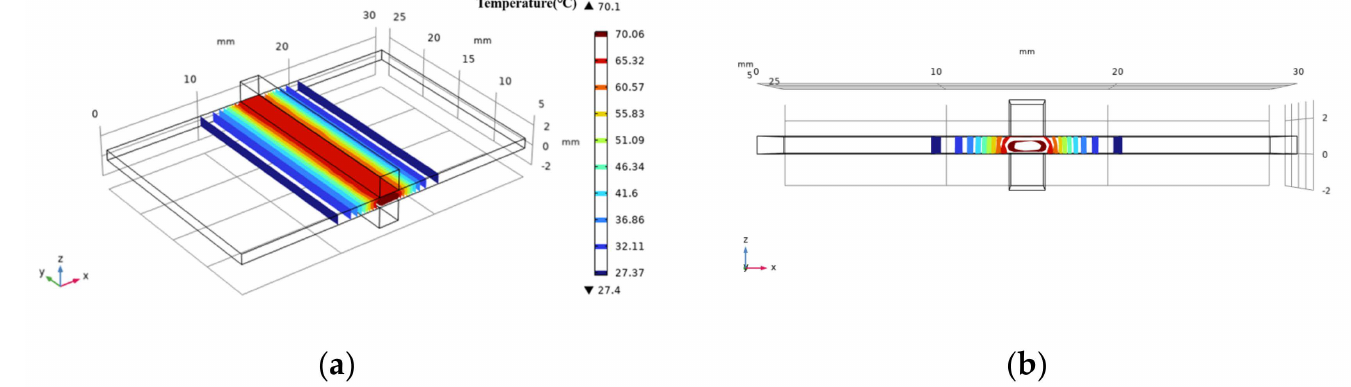
Figure 5. Simulation diagram of medium temperature surface during experiment (COMSOL). The section is part of an ellipsoid on ( a ). In the z -axis direction, there is a certain temperature difference inside and outside the tissue, and the isothermal surface deviates a little on ( b